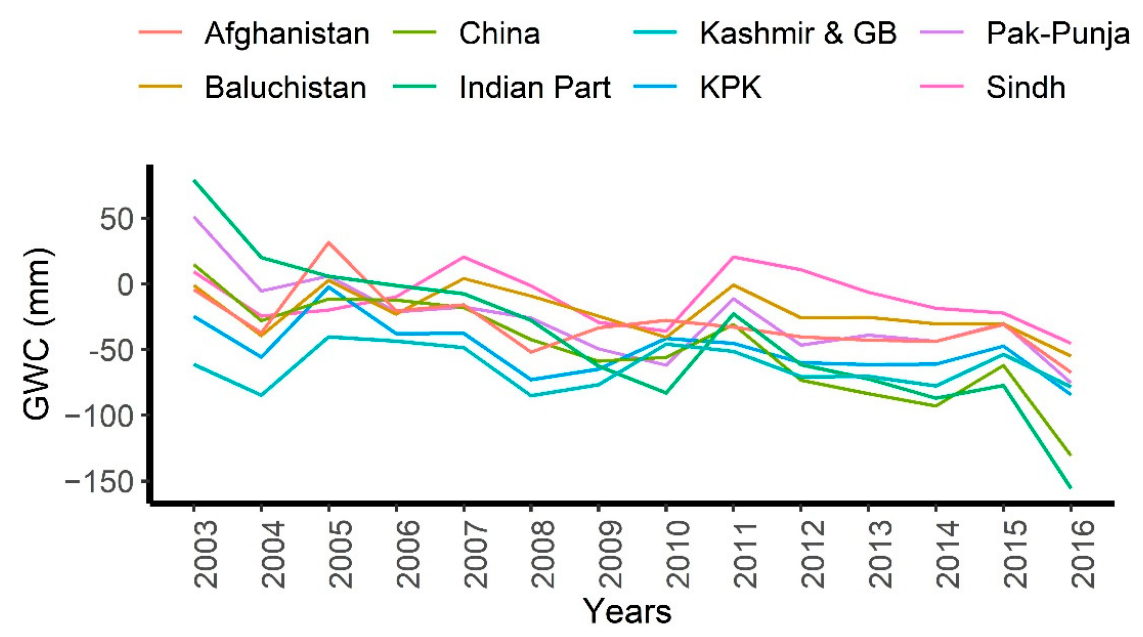
Figure 10. The annual time series of spatially averaged changes in groundwater storage in different regions . The GRACE-based estimates of groundwater storage changes were compared to in situ measurements (1 piezometer data for KRB and 1 observation well for LBDC). In situ measurements for KRB and LBDC were available from 2003 to 2015 and 2005 to 2013, respectively. When the GWC and in situ measurements were compared, the correlation coefficients for LBDC and KRB were 0.78 and 0.35, respectively (Figure 11).